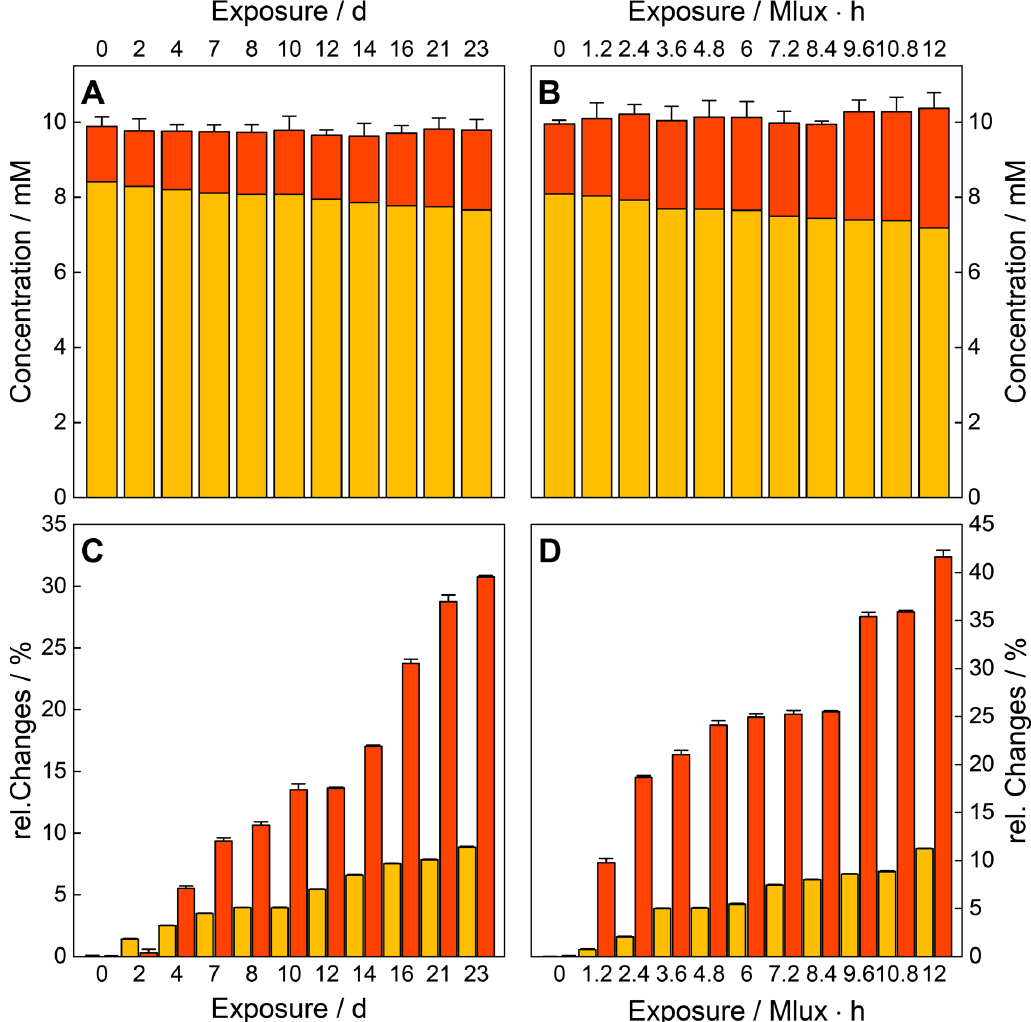
Figure 5. Contribution of the investigated tablet for TC (orange) and EATC (red), under treatment with humidity / temperature ( A ) and light ( B ). The sum of both mean values (with its respective error bars) deviates only slightly from the total concentration of 10 mM. Due to the exposure, a decrease (increase) of the concentration of TC (EATC) is observed with time. The general trend of the concentration changes is independent of the treatment, but the values of relative production of EATC (relative to the first concentration) are up to five times higher than the ones for the degradation of TC. The two treatments with humidity and temperature (RH / RT, C ) and light (Vis, D ) are shown. Light exposure results in 1.5 times stronger decrease (increase) of TC (EATC), compared to the treatment with temperature/humidity, respectively.